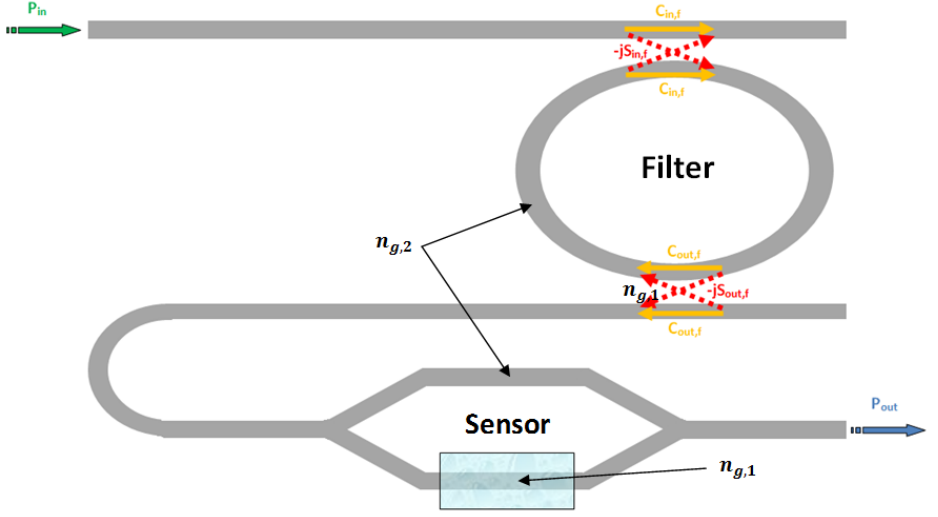
Figure 11. Sketch of a MZI-Enhanced Vernier effect-based